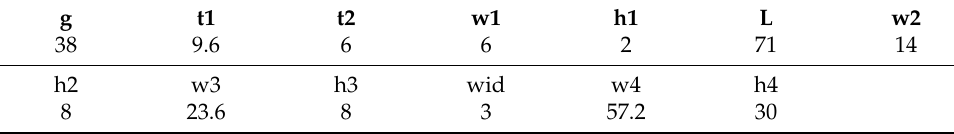
Table 1. Size of patch antenna with improved structure